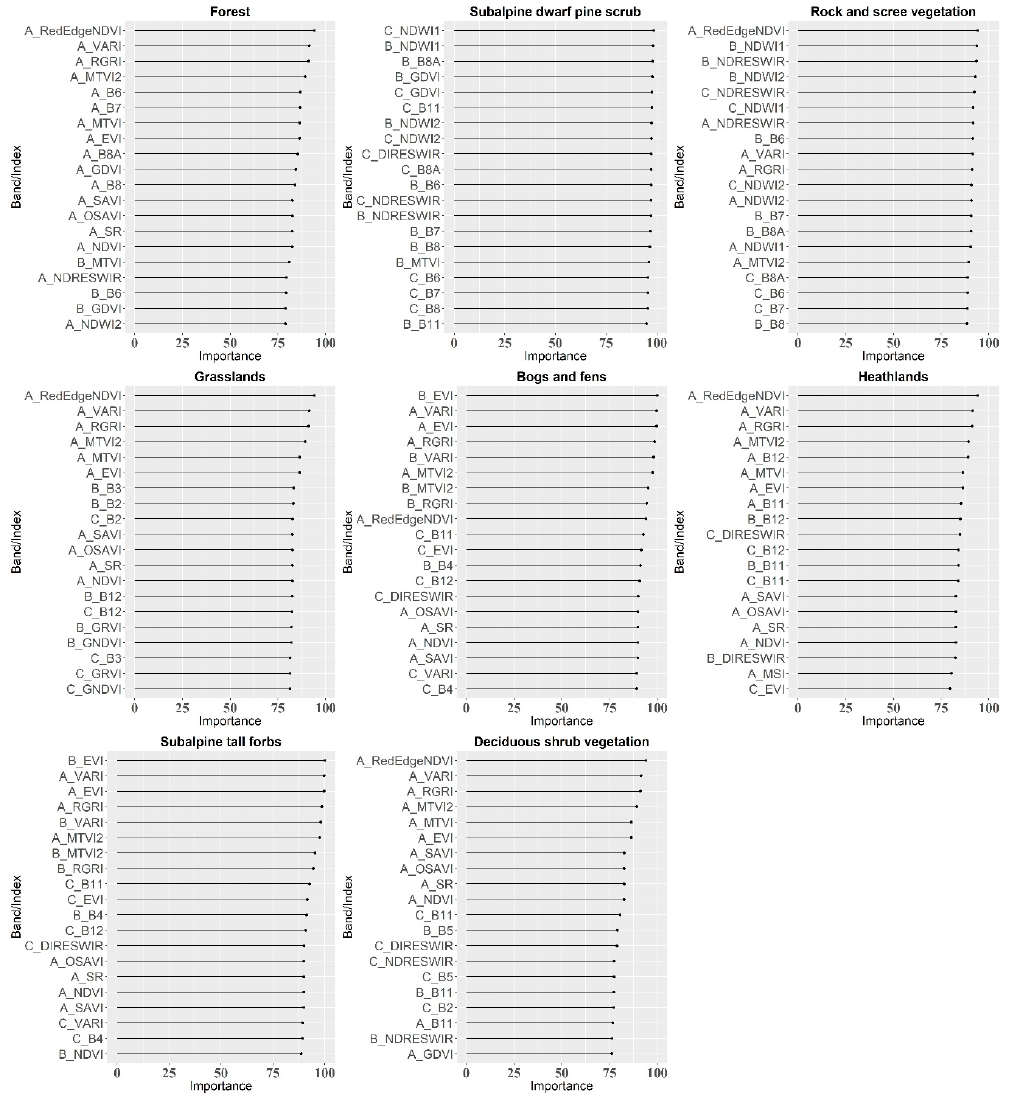
Figure A4. The 20 most important variables in classification of each vegetation type using ABC_IND dataset.